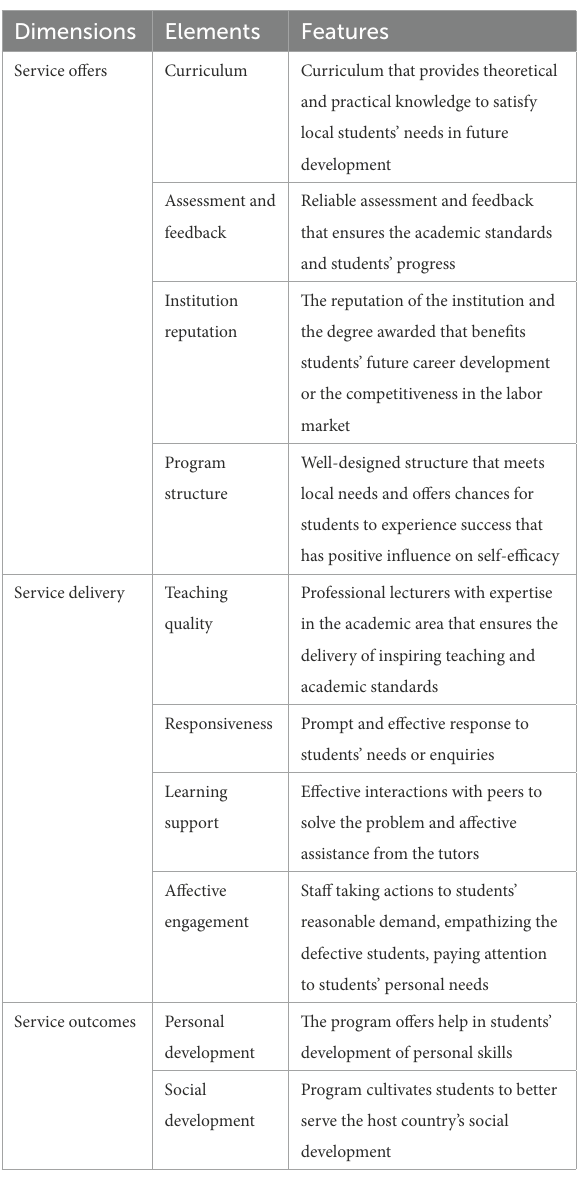
TABLE 6 Dimensions of high-quality